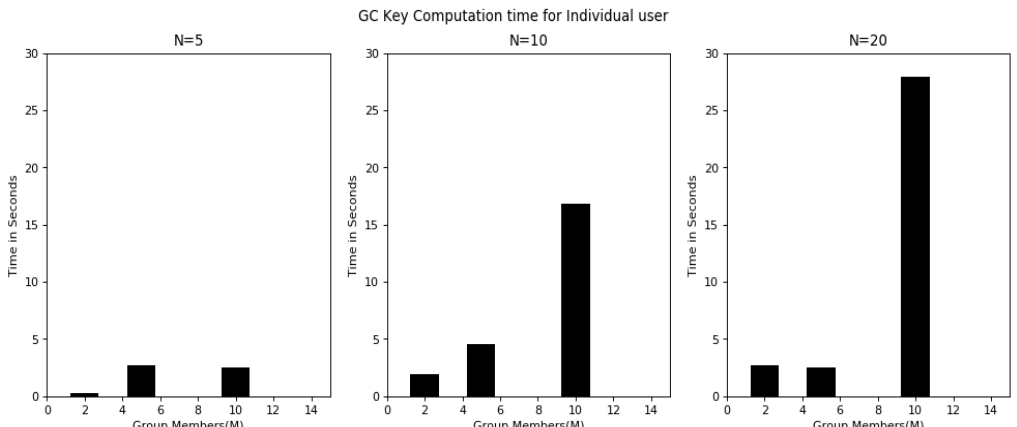
Figure 8. Time for shared key finalization with individual user through public discussion.